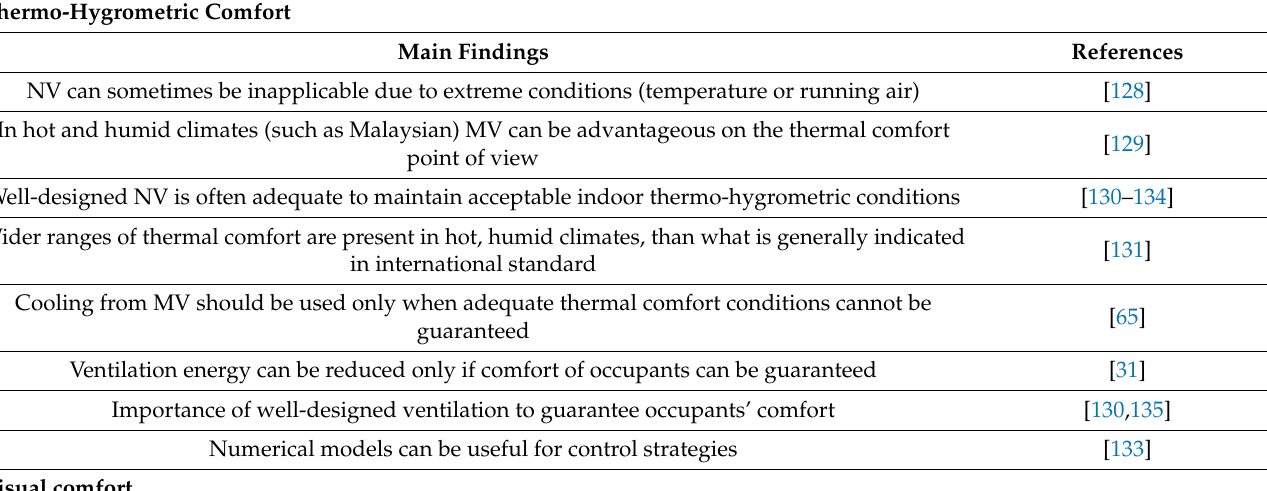
Table 3. Key findings related with various or unspecified